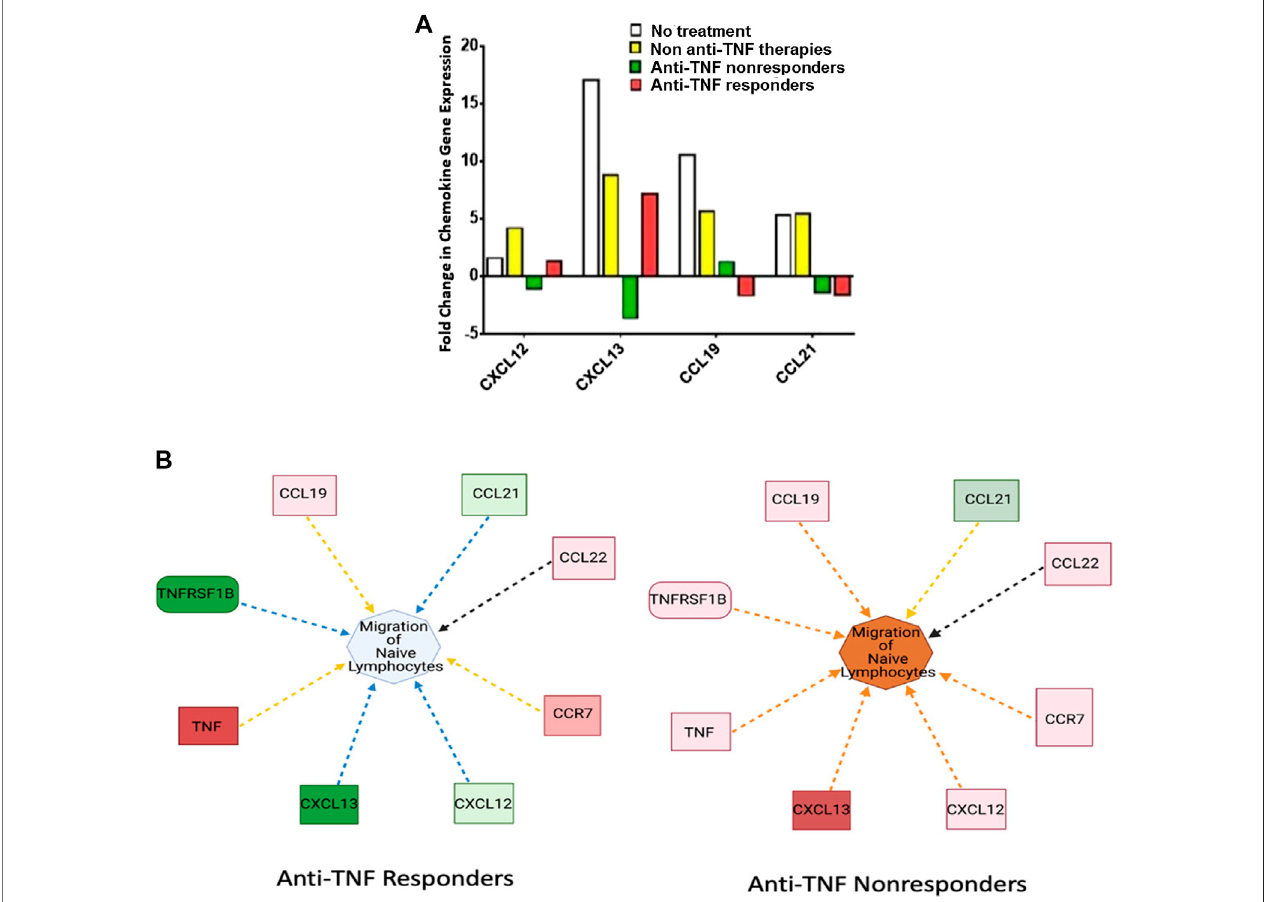
FIGURE 3 | CXCL12 and CXCL13 are Downregulated in IBD Patients Responding to Anti-TNF α Therapy. (A) CXCL12, CXCL13, CCL19, and CCL21 were signi fi cantlyupregulatedinboth untreated IBD patients ( n (cid:2) 2,onepool) and IBDpatientstreated withnon-anti-TNFmedications( n (cid:2) 10, twopools). CXCL12, CXCL13, and CCL19 displayed opposite expression pro fi les based on anti-TNF responsiveness, with upregulation in anti-TNF nonresponders ( n (cid:2) 10, two pools) and downregulation in responders ( n (cid:2) 5, two pools) for CXCL12 and CXCL13. CCL21 remained downregulated regardless of response to anti-TNF agents. (B) Predictedeffectonthemigrationofnaïvelymphocytestoin fl amedtissuebasedonchangesofthenoncanonicalchemokineswhichareinvolvedinlymphocytetraf fi cking. Inanti-TNFresponders,lymphocytetraf fi ckingisreduced.Bycontrastanti-TNFnonrespondersdemonstrateincreasedlymphocytetraf fi cking.Ingeneral,theincreasein noncanonicalsignalingmoleculesresultsinalargeincreaseinpredictedlymphocytemigration.Note:Blueandorangedashedlineswitharrowsindicateindirectinhibition and activation, respectively. Yellow and black dashed lines with arrows depict inconsistent effects and no prediction, respectively.